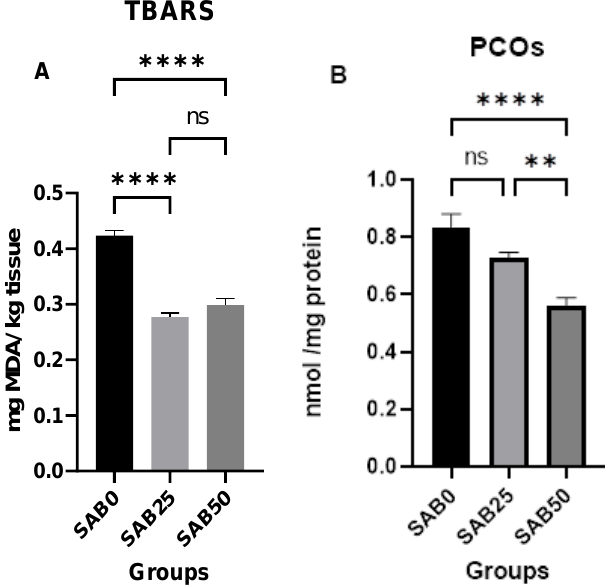
Figure 1. Effects of dietary salicin standardized extract from SAB on liver concentrations of ( A ) thio- barbituric acid reactive substances (TBARS), and ( B ) protein carbonyls (PCOs) in broiler chickens. Bars represent means ± SEM. Abbreviations: SAB0 — basal diet, without SAB; SAB25 — basal diet + 25 g SAB/100 g diet; SAB50—basal diet + 50 g SAB/100 g diet; ** p < 0.01; **** p < 0.0001.